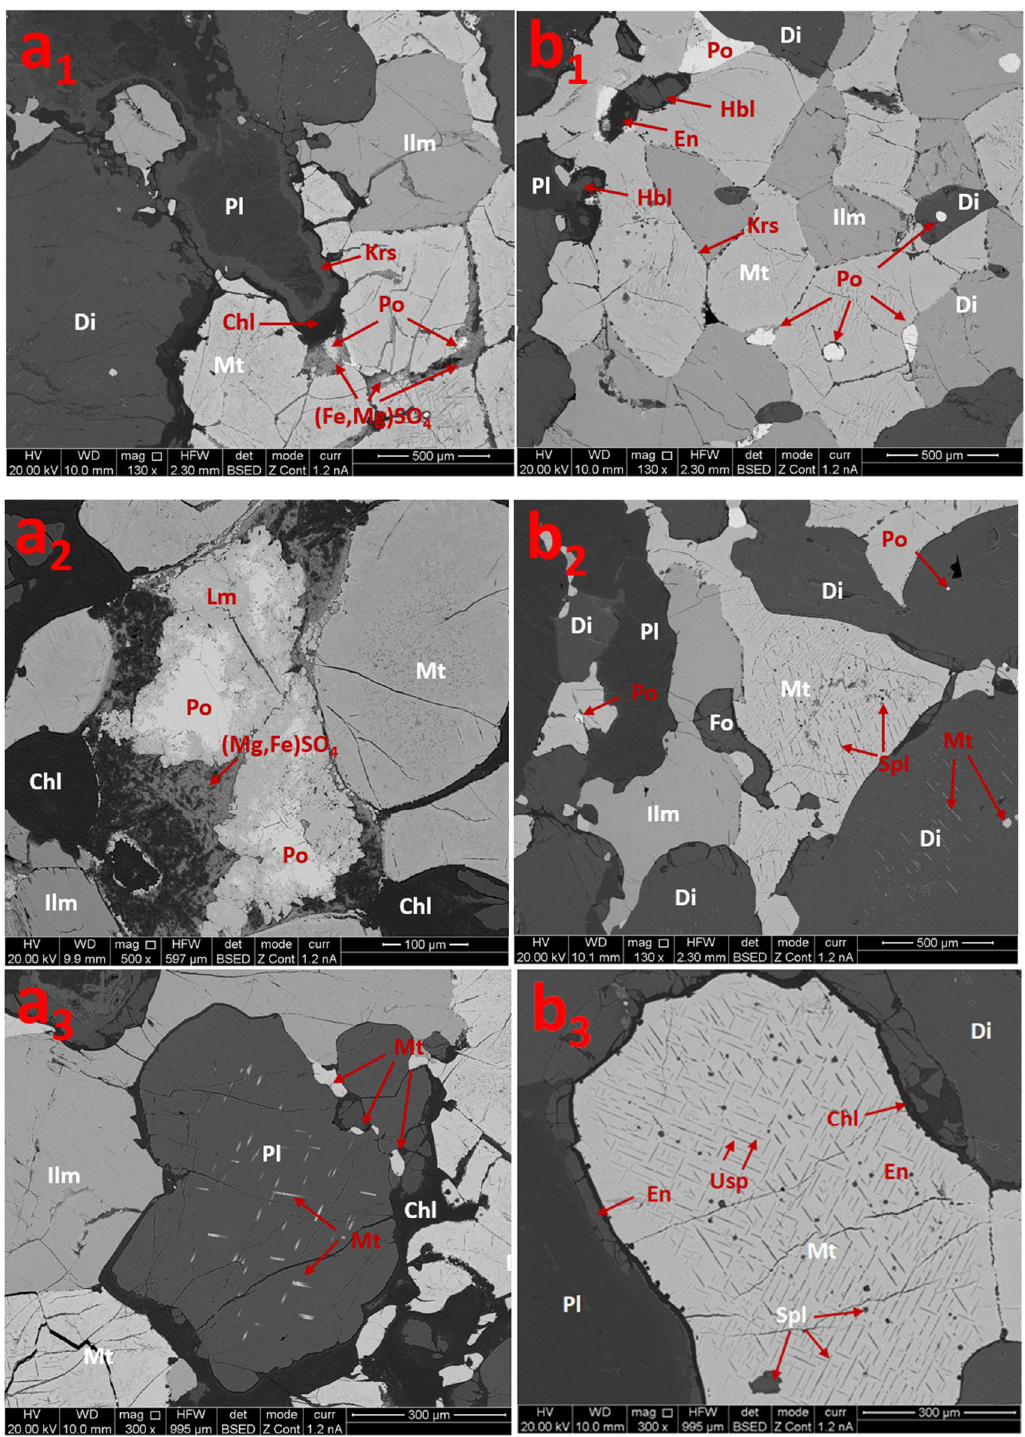
Figure 5. SEM images of ( a 1 – a 3 ) A-1 and ( b 1 – b 3 ) A-2 ores (Lm = limonite, Spl = magnesia–alumina spinel, Hbl = hornblende, Usp= uivospinel). spinel, Hbl = hornblende, Usp=